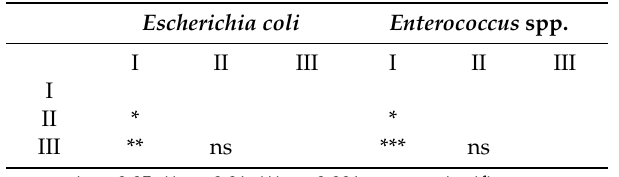
Figure 3. Average number of faecal indicator bacteria ( a ) at the research sites, ( b ) in the research seasons. Table 3. Statistical differences in the number of indicator bacteria between the analyzed datasets based on post ‐ hoc for Kruskal ‐ Wallis test.